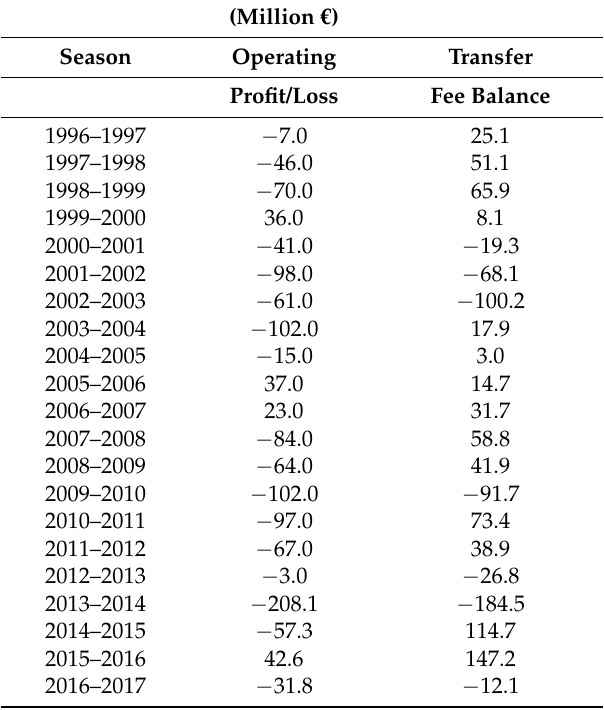
Table 5. The French league’s operating profit/loss and transfer fee balance,